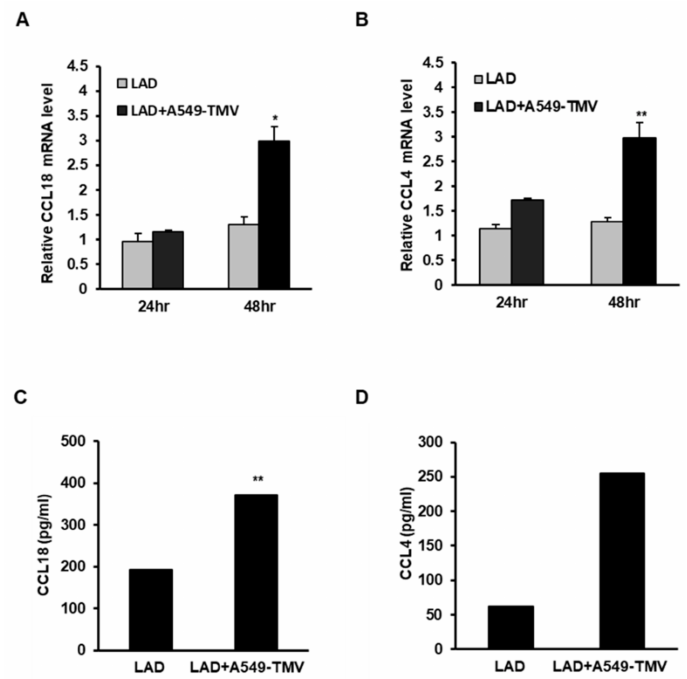
Figure 1. Validation of the effect of NSCLC-TMVs on selected gene expression in LAD2 cells. ( A , B ) LAD2 cells were stimulated with 100 µ g/mL A549-TMVs for 24–48 h for RNA analysis and for 72 h for protein analysis. mRNA expression of CCL18 and CCL4 was assayed using real-time PCR and normalized to GUSB . ( C , D ) Protein release was assayed by ELISA. Data are presented as means ± SEs of three independent experiments done in duplicate (* p < 0.05; ** p <